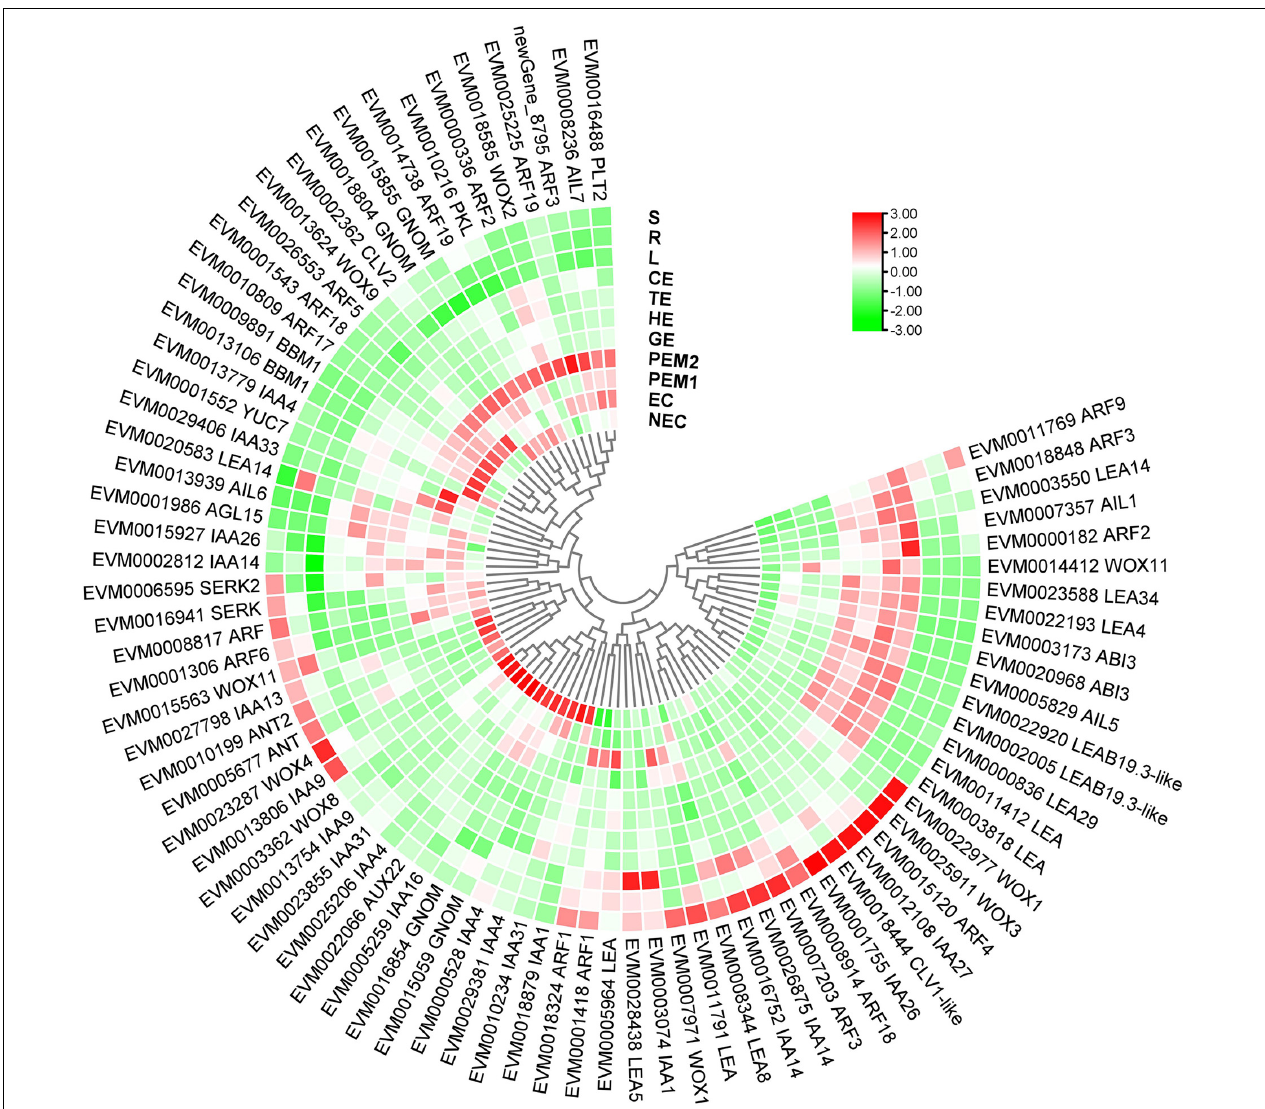
FIGURE 9 | Heatmap of the differentially expressed SE-related genes during hybrid sweetgum SE. The heatmap was clustered by pearson method of TBtools software. Heatmap indicate the gene expression level by Log2[FPKM] with a color scale, each row represents a single gene, the IDs and names of selected DEGs are indicated to the outside of fan, and each circle represents a